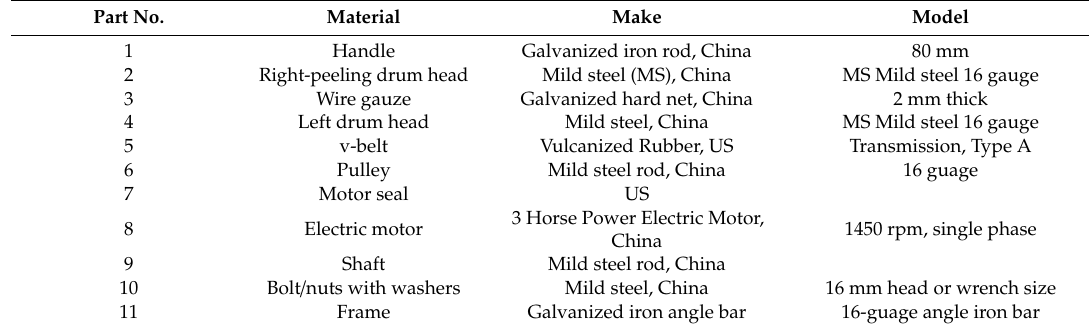
Table 5. Bill for